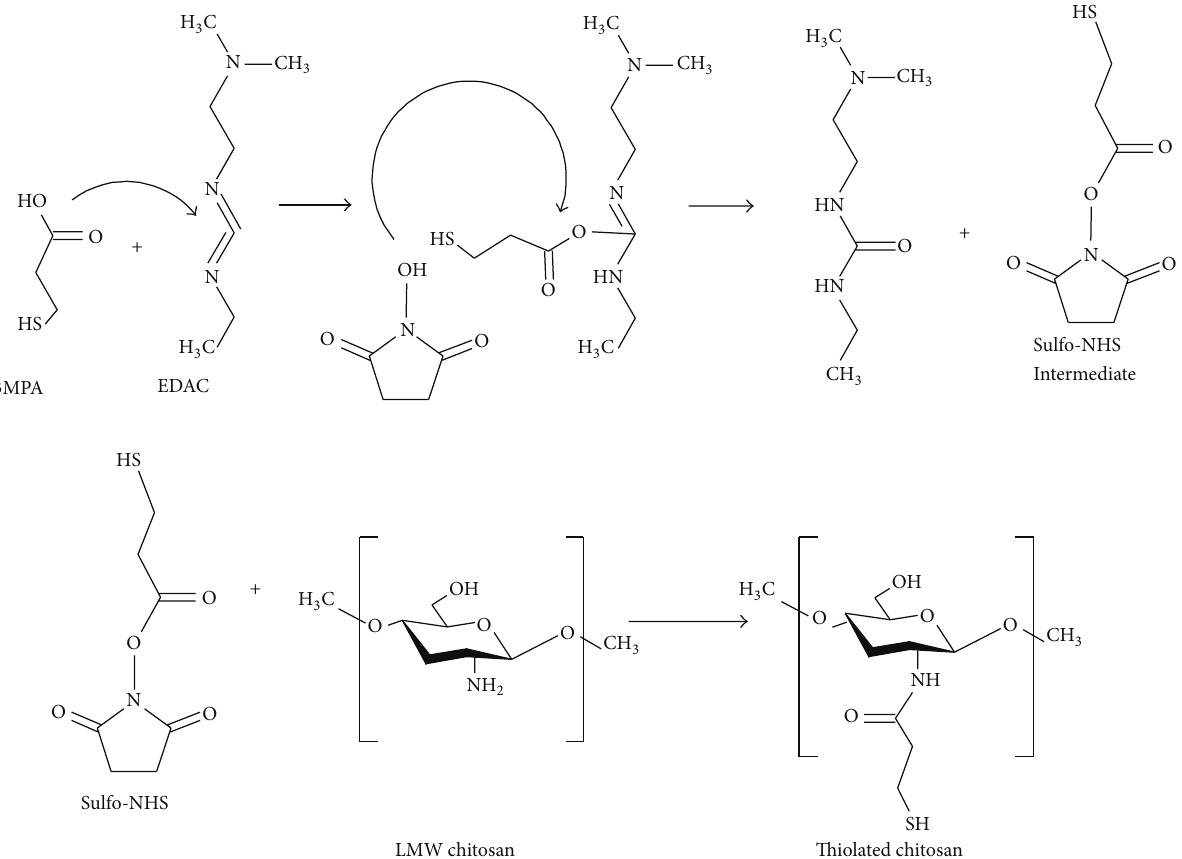
Figure 1: Reaction mechanism of thiolated